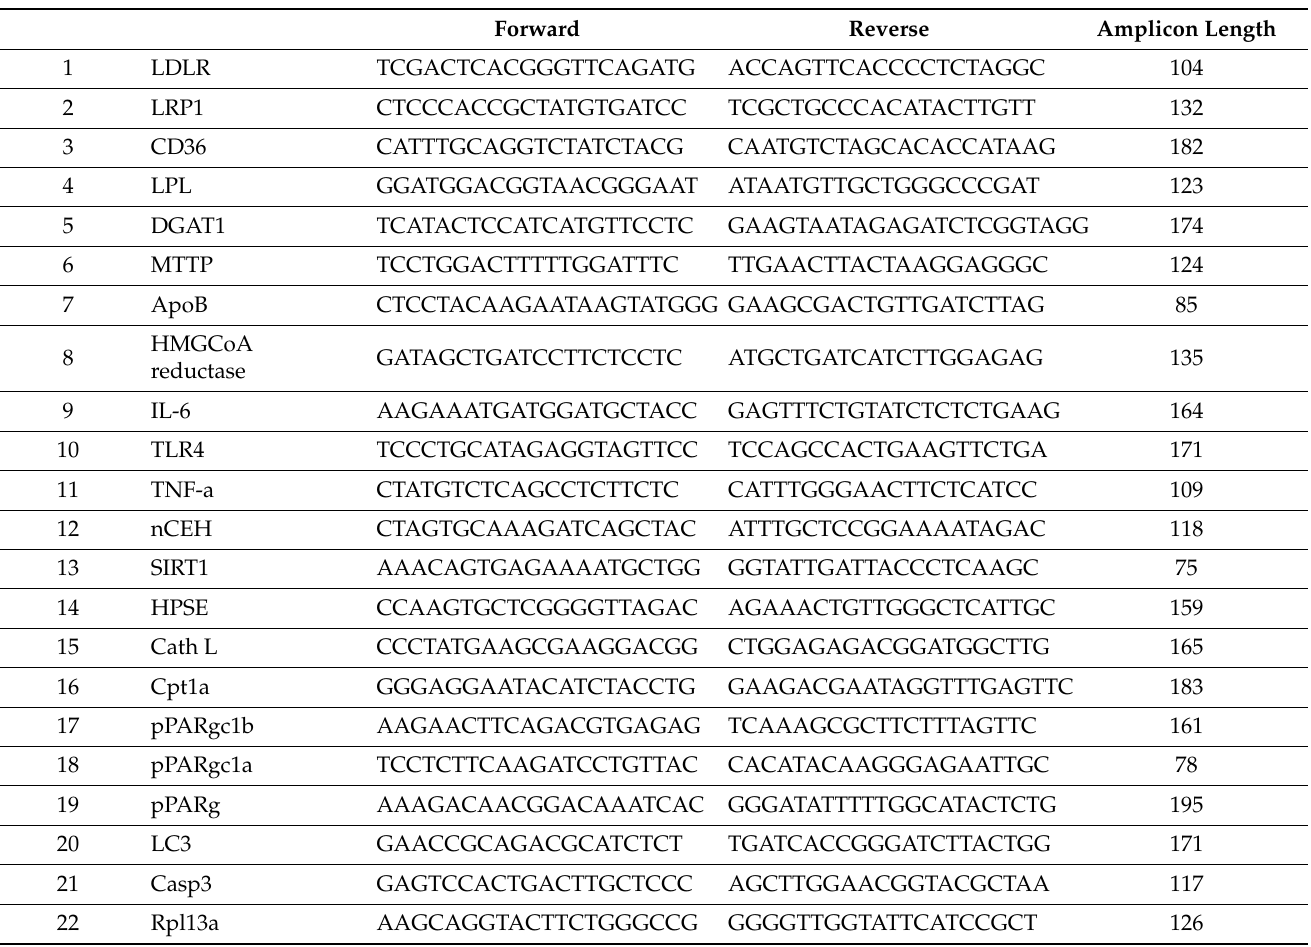
Table 1. Sequence of forward and reverse primers used in qPCR